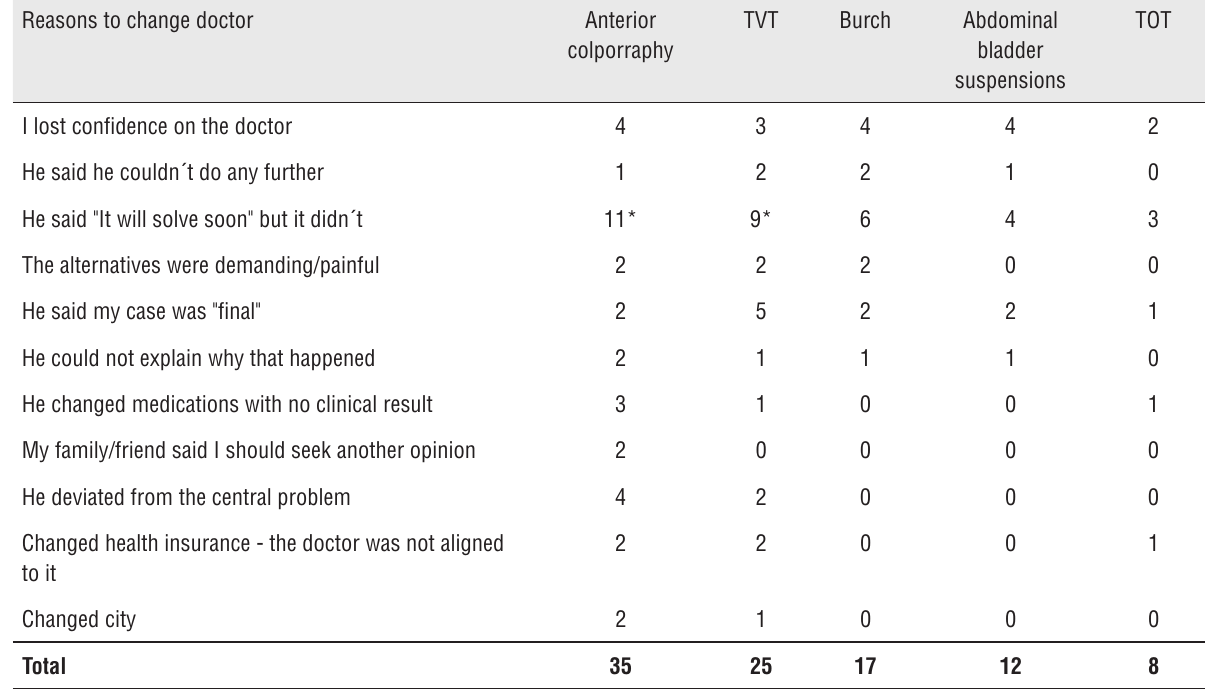
Table 5 – Reasons why you change